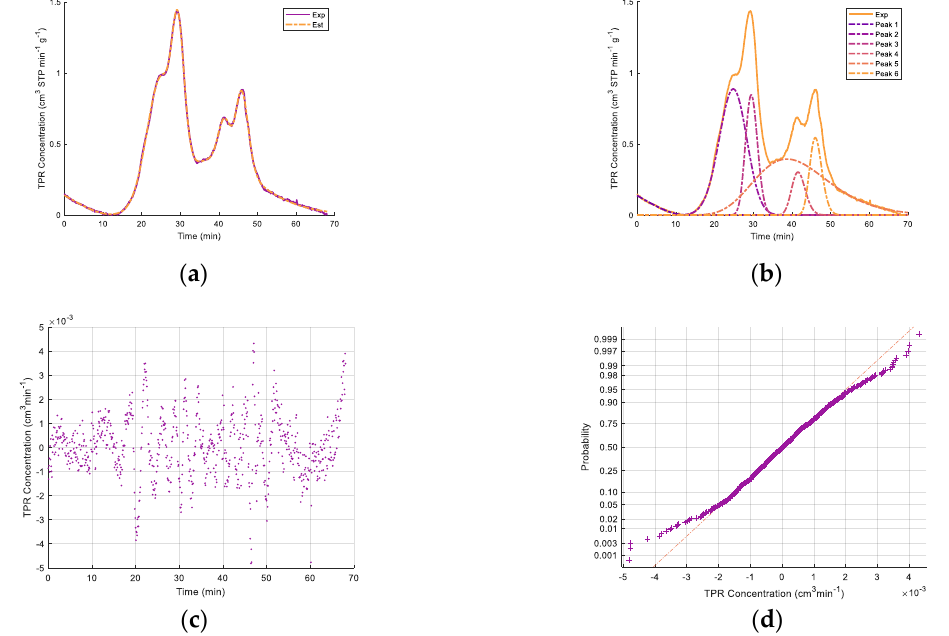
Figure A4 . Deconvolution of the TPR curve, with 950 °C as maximum temperature for a fresh 4% Fe/10% Figure A4. Deconvolution of the TPR curve, with 950 ◦ C as maximum temperature for a fresh 4%